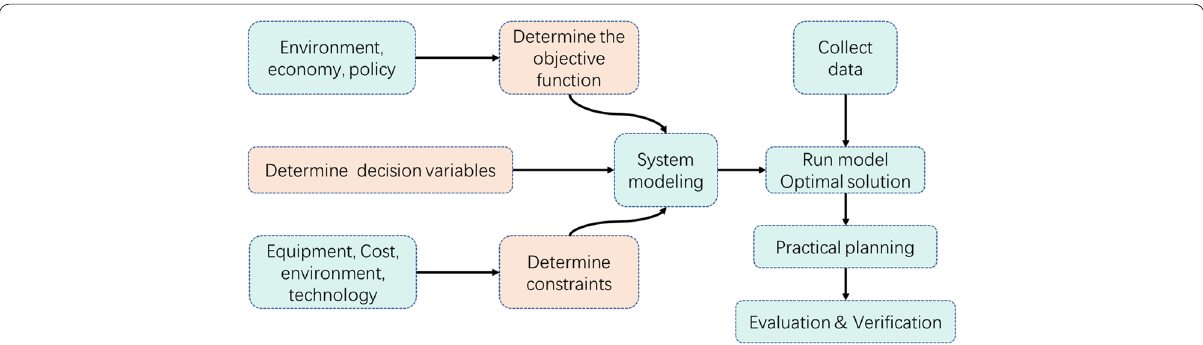
Fig. 7 The flowchart of the planning